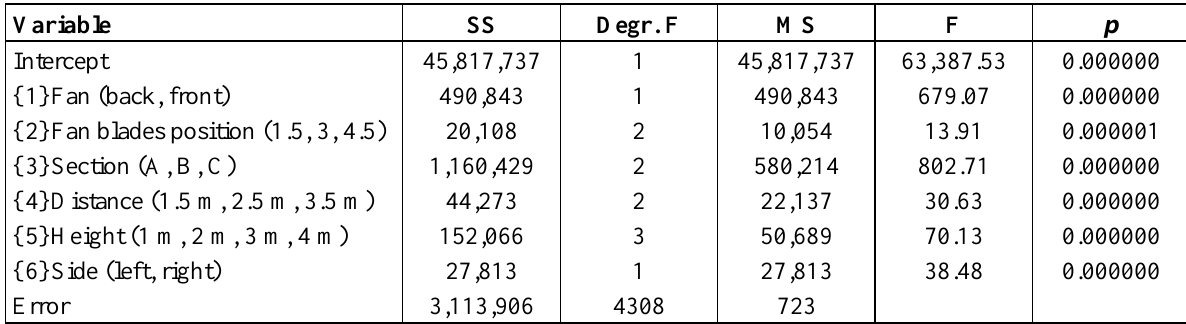
Table 5. Univariate test of significance for the vertical angle of the air velocity vector in the static